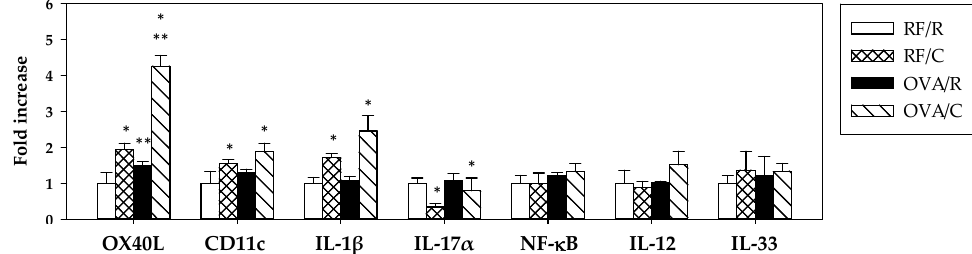
Figure 5. mRNA gene expression in MLN lymphocytes. Values are expressed as mean ˘ standard error ( n = 6–9). Statistical differences: * means a significant difference induced by the cocoa diet ( p < 0.05 by two-way ANOVA), ** means a significant difference with respect to the reference diet or induced by the oral sensitization process ( p < 0.001 by Bonferroni test). Groups: RF/R = reference group; RF/C = reference group fed cocoa diet; OVA/R = sensitized group; OVA/C = sensitized group fed cocoa diet.